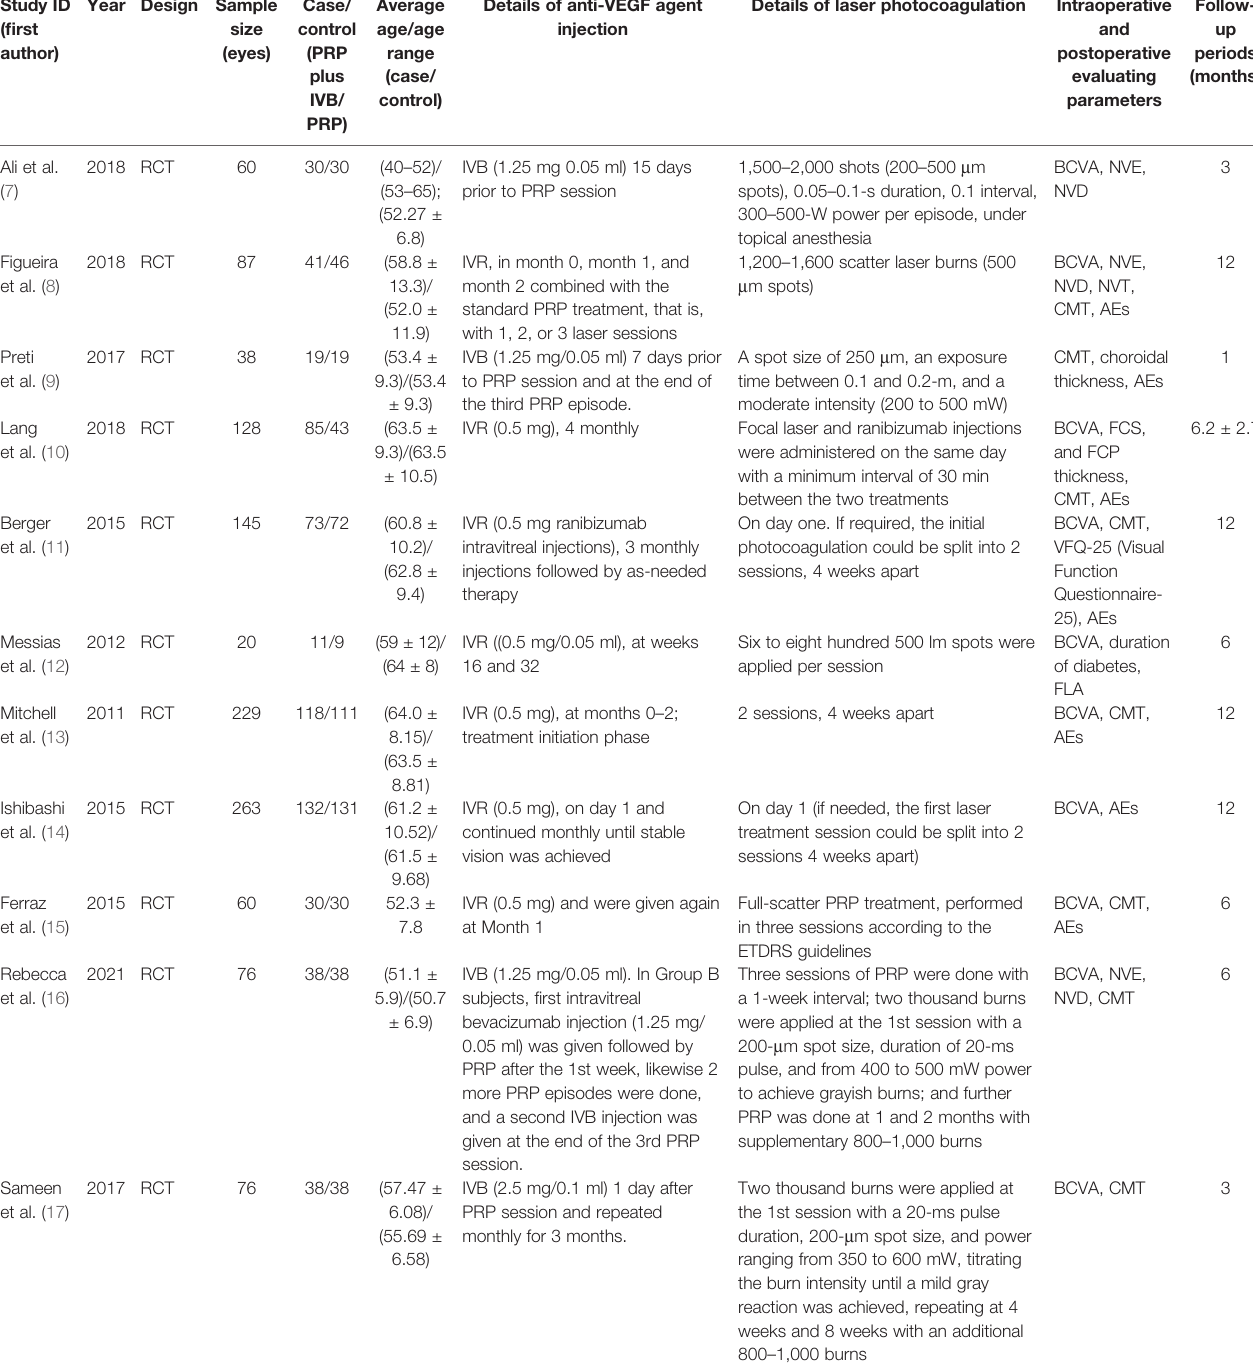
TABLE 1 | Characteristics of included